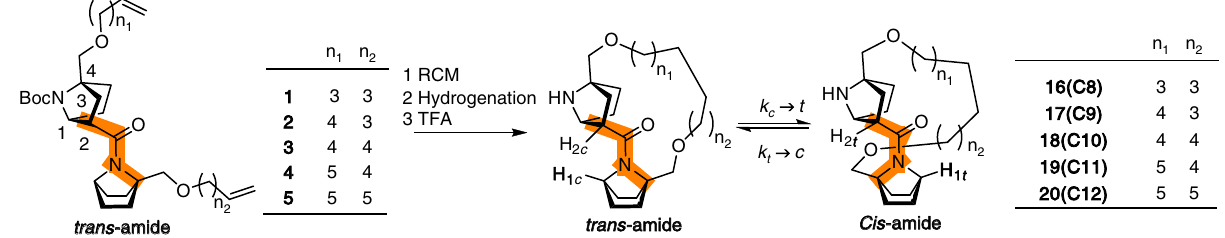
Fig. 2 Lactams containing two 7-azabicyclo[2.2.1]heptane bicyclic units. Stapling of model bridgehead-substituted bicyclic dimers with various lengths